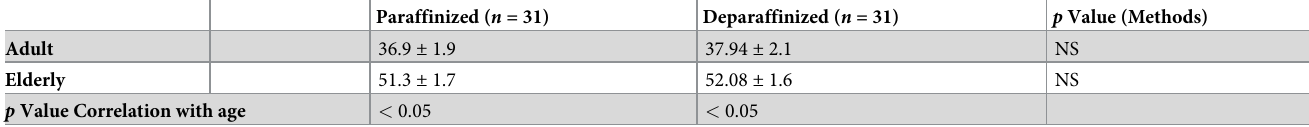
Table 1. Hydroxyproline content in human ascending